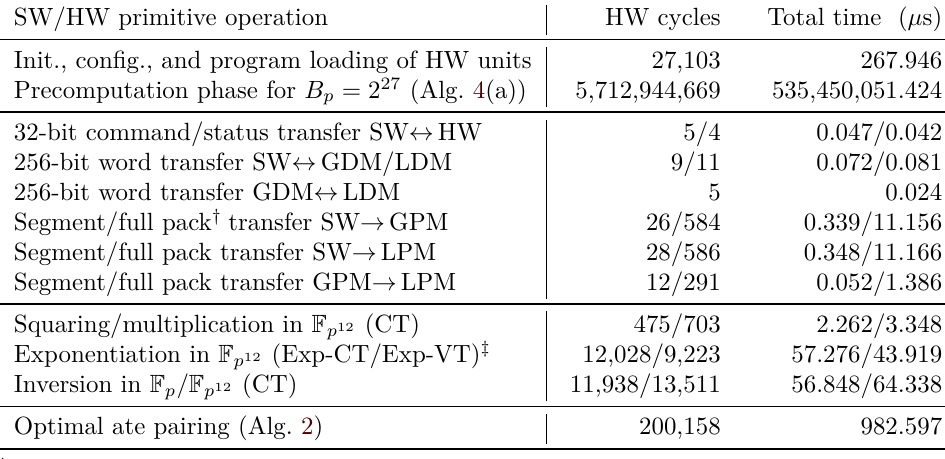
Table 2: Total execution times and HW latencies of different SW/HW